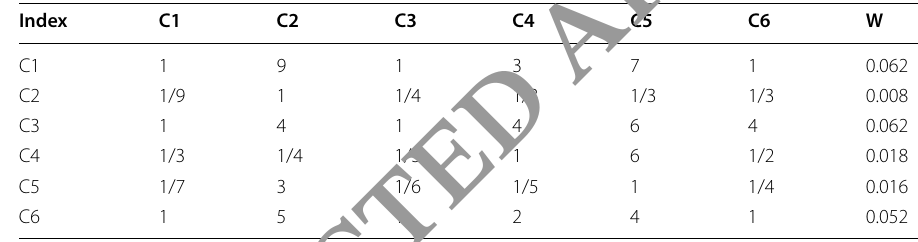
Table 3 Judgment